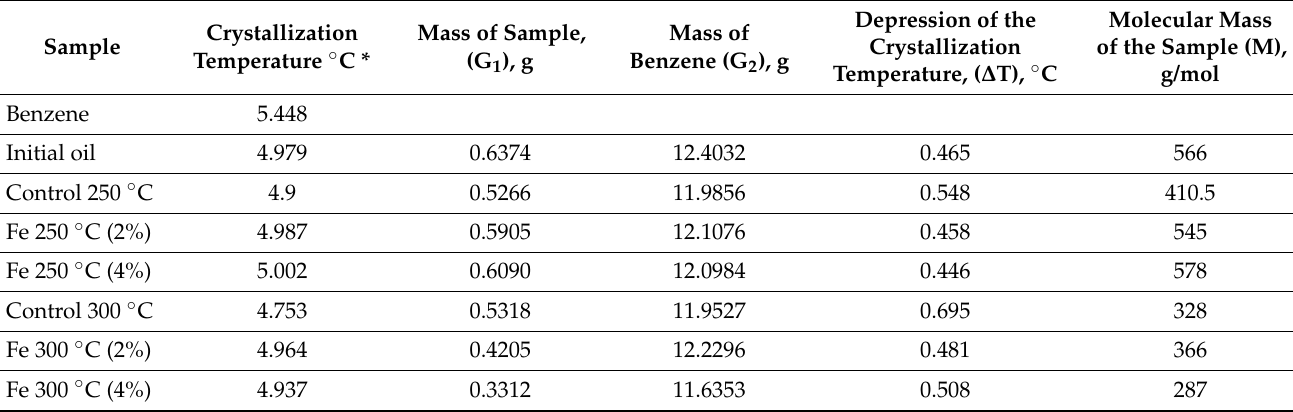
Table 1. Results of molecular mass measurements of oil samples.